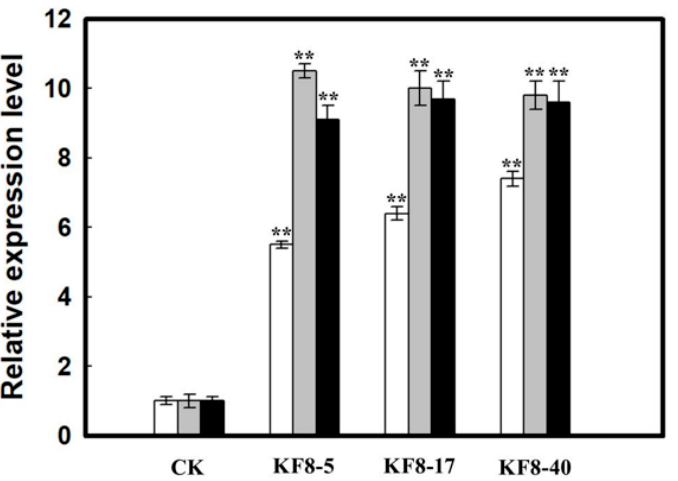
Figure 8. Relative expression of AtAAP1 gene in three lines (i.e., KF8-5, KF8-17, and KF8-40) of transgenic maize plants with overexpression of AtAAP1 at milk (white bars), dough (gray bars), and mature (black bars) stages based on qRT-PCR analysis using actin gene as the internal reference gene. Symbol “**” indicates significant differences in comparison to negative maize plants (CK) at p value of 0.01.